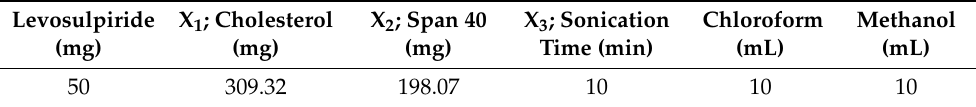
Table 8. Composition of drug and excipients in check point batch (NC).